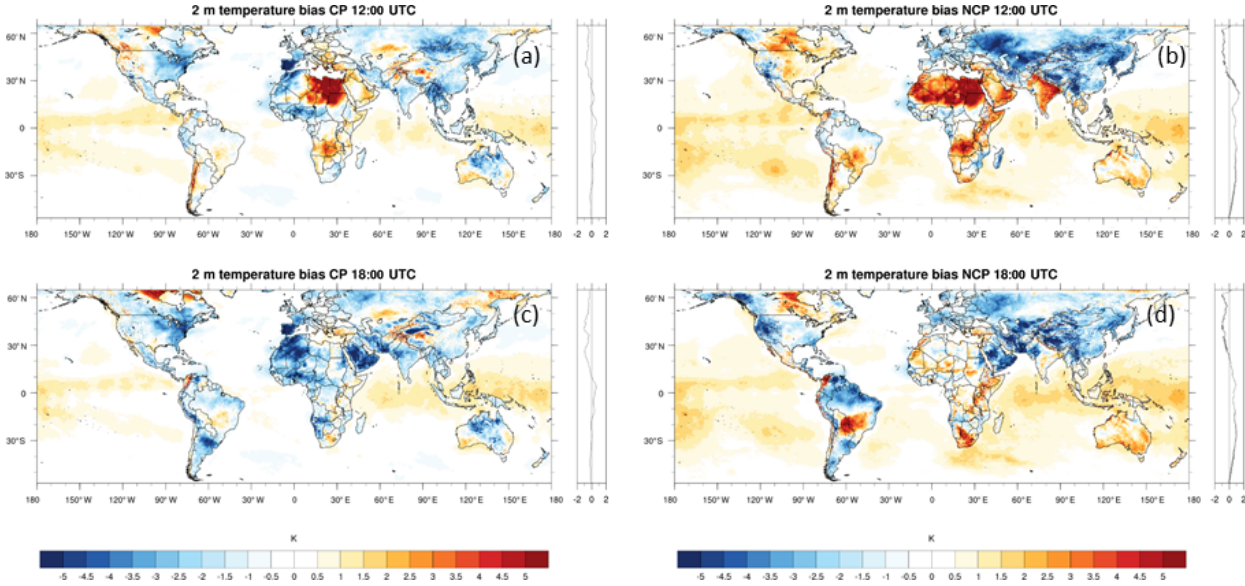
Figure 8. Mean 2m temperature bias (K) against the operational ECMWF analysis for the 12:00UTC time steps (a, c) and the 18:00UTC time steps (b, d) averaged between April and June 2015. Panels (a) and (c) show the CP simulation and panels (b) and (d) denote the NCP simulation. On the right side of each panel, the zonal mean bias is